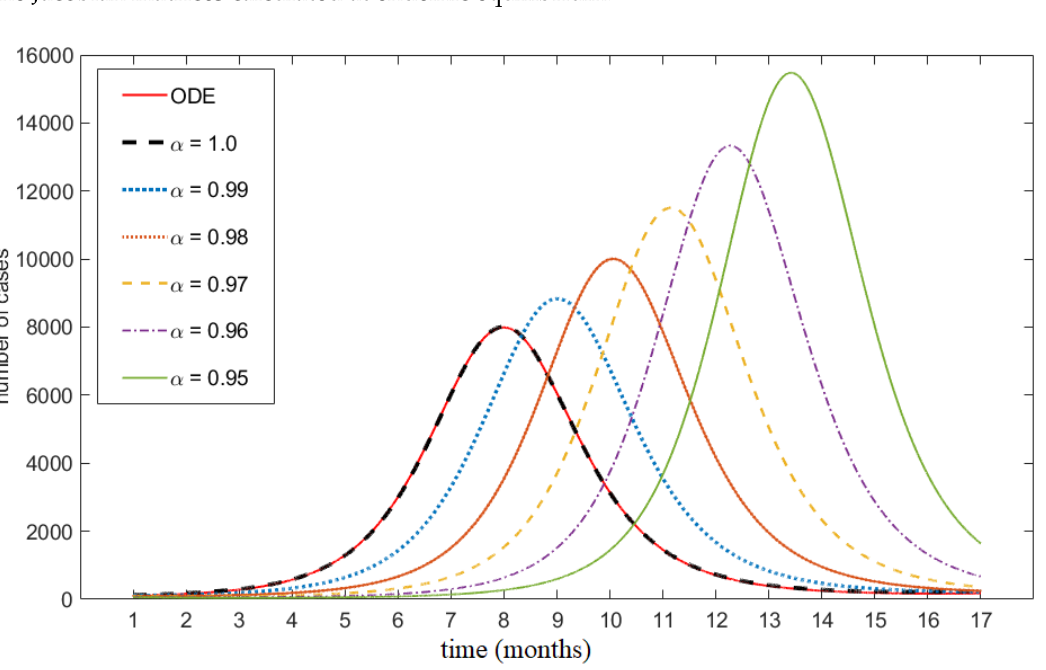
Figure 2. Number of cases using classical ordinary differential equation (ODE) model and fractional differential equation (FDE) model with different fractional orders α . The simulations are done using µ = µ (cid:63) = 0.0027, β = β (cid:63) = 119.2257, δ = δ (cid:63) = 16.7301, σ = σ (cid:63) = 10.1873, and N =